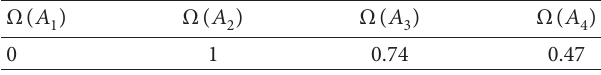
Table 17: Overall prospect dominance degrees.